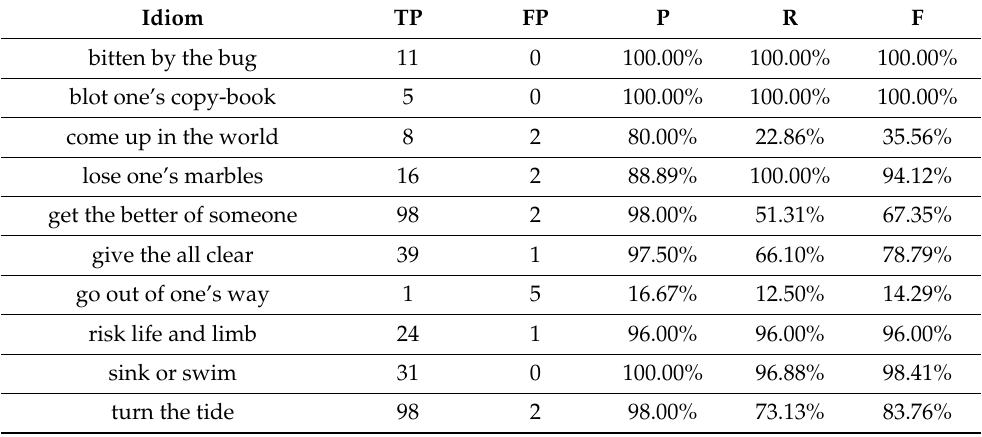
Table 4. A sample of flexible search results.